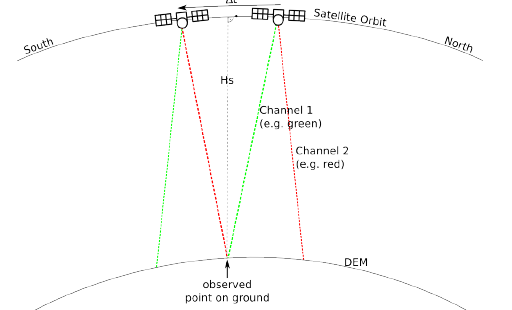
Figure 1: Principle of acquisition geometry of image bands sepa- rated in a FPA different positions in the blue, green and red band.